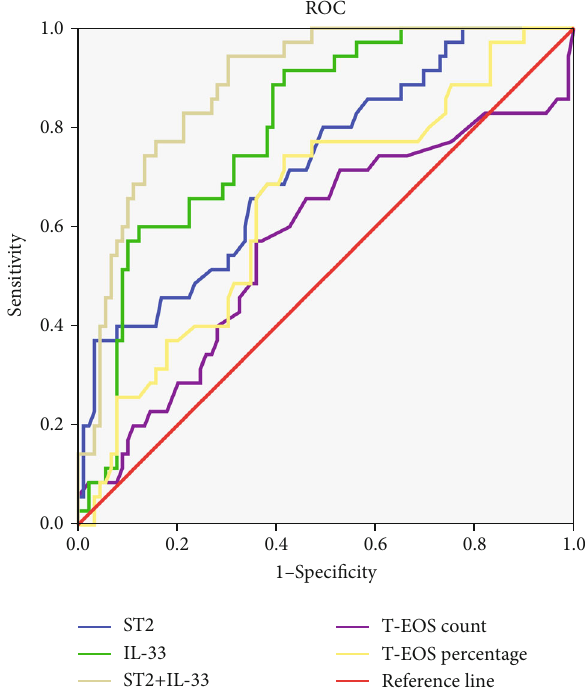
Figure 4: ROC curves of novel biomarkers for predicting postoperative recurrence in CRSwNP patients. ROC: receiver operating characteristic; CRSwNP: chronic rhinosinusitis with nasal polyps; IL-33: interleukin-33; sST2: soluble suppressor of tumorigenicity 2; T-EOS: tissue